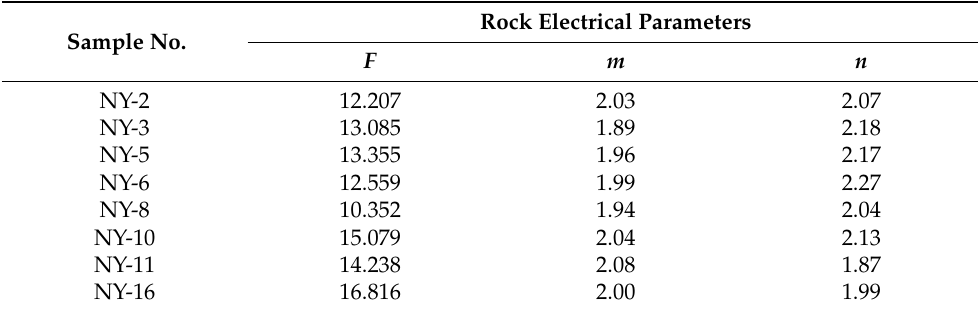
Table 2. Rock electrical parameters of core samples of the Quaternary mudstone biogas reservoir.